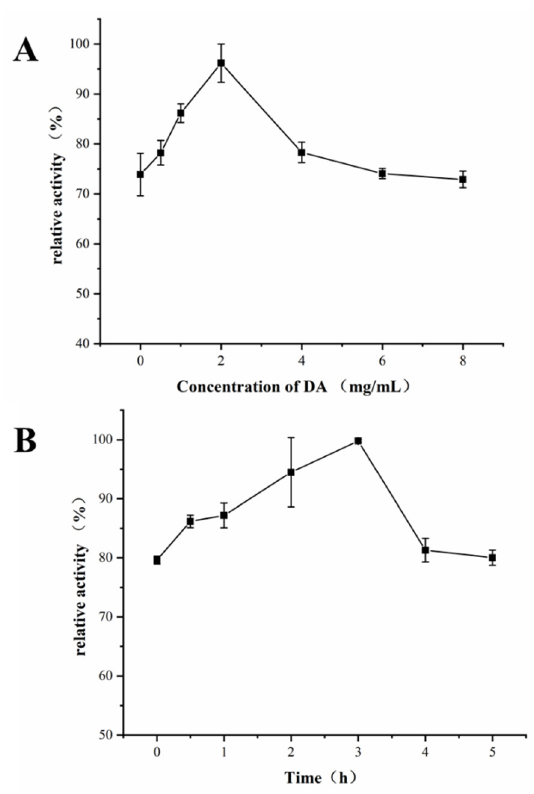
Figure 2. Effects of concentration of DA ( A ) and stirring time ( B ) on the activity of PDA@HF-immobilized XOD (the optimal activities of the immobilized enzyme counterpart were taken as 100%).